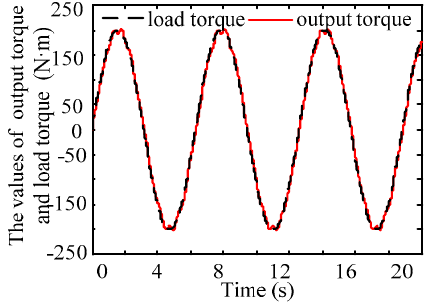
Figure 12. The curves of the load torque and output torque.